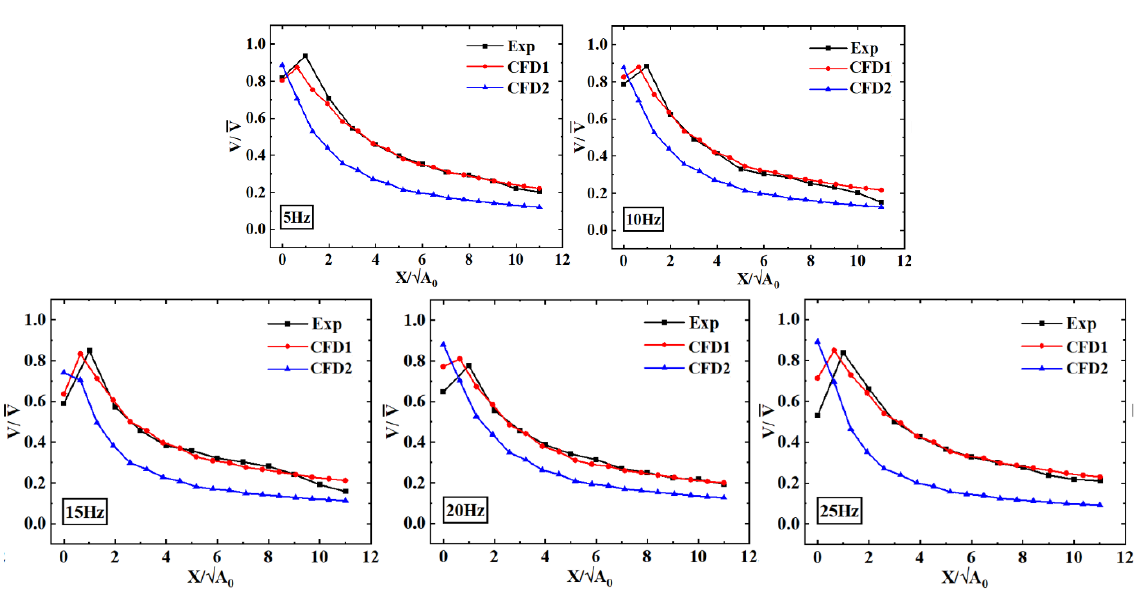
Figure 10. Comparison of measured and numerical profiles for RGD at nine positions. ( a ) Pole 2. ( b ) Pole 3. ( c ) Pole 4. ( d ) X 1 . ( e ) X 2 . ( f ) X 3 .